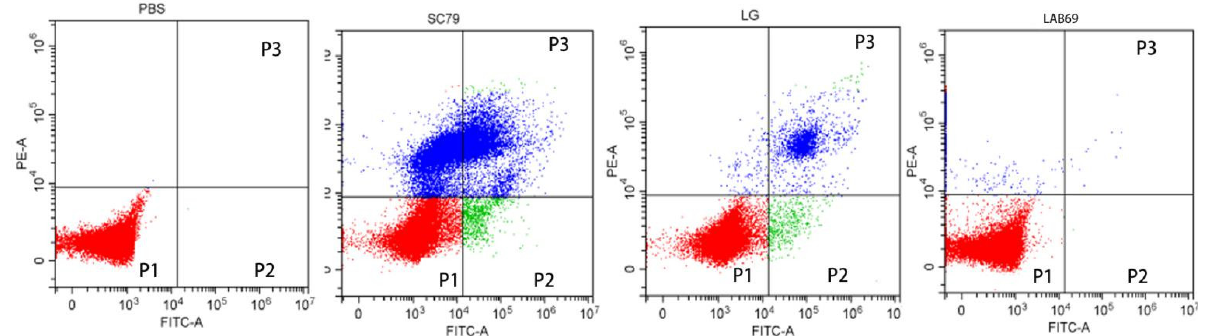
Figure 5. Four quadrants results of Caco-2 cells treated with different bacteria in flow cytometry. Note: P1 gate, the red part of P1 gate is the ratio of the number of living cells. The higher the red ratio, the more living Caco-2 cells; P2 gate, the green part of P2 gate is the ratio of apoptotic cells. The larger the green area, the more apoptotic cells; P3 gate, The blue part of P3 gate is the ratio of death cells. The larger the blue area, the more death cells.